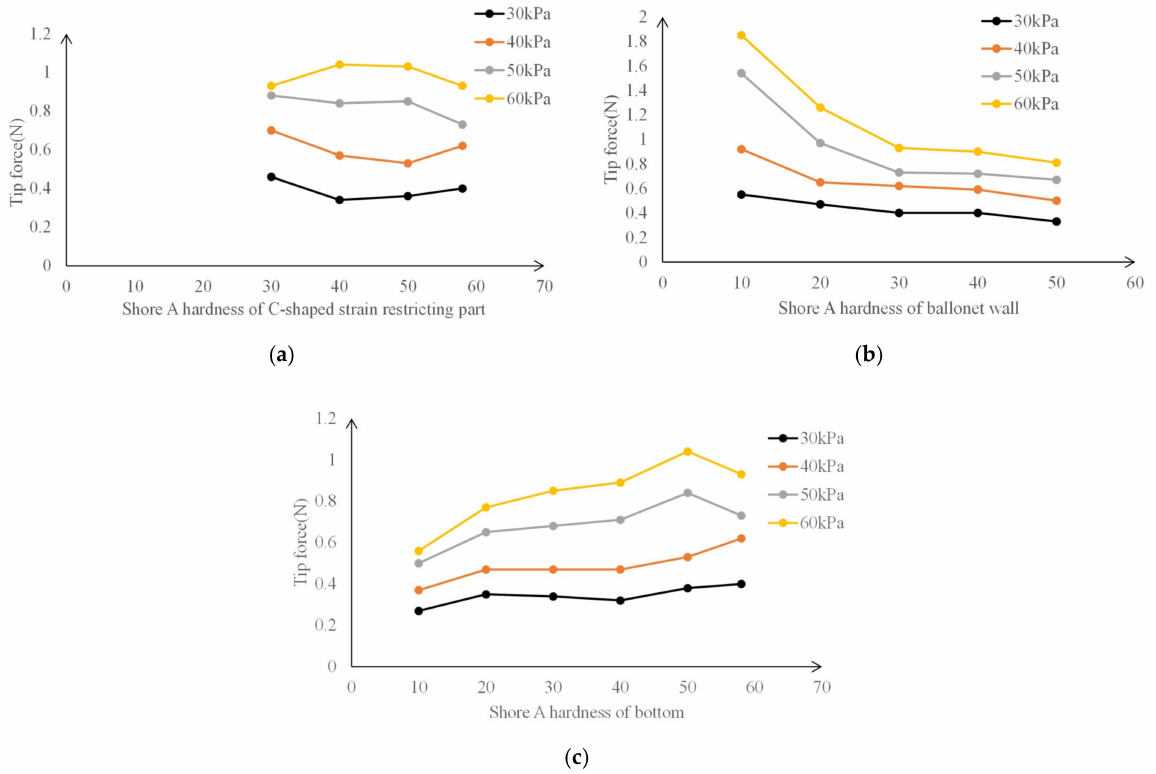
Figure 8. Experimental data of actuator tip force: ( a ) The hardness of C-shaped strain-restricting part as variable. ( b ) The hardness of ballonet wall as variable. ( c ) The hardness of bottom as